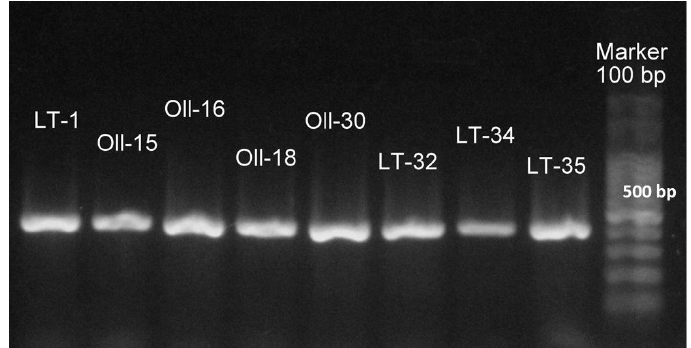
Figure 2. Gel image of the amplification of cytotoxin K-1 gene (426 bp) in the B. cytotoxicus isolated from